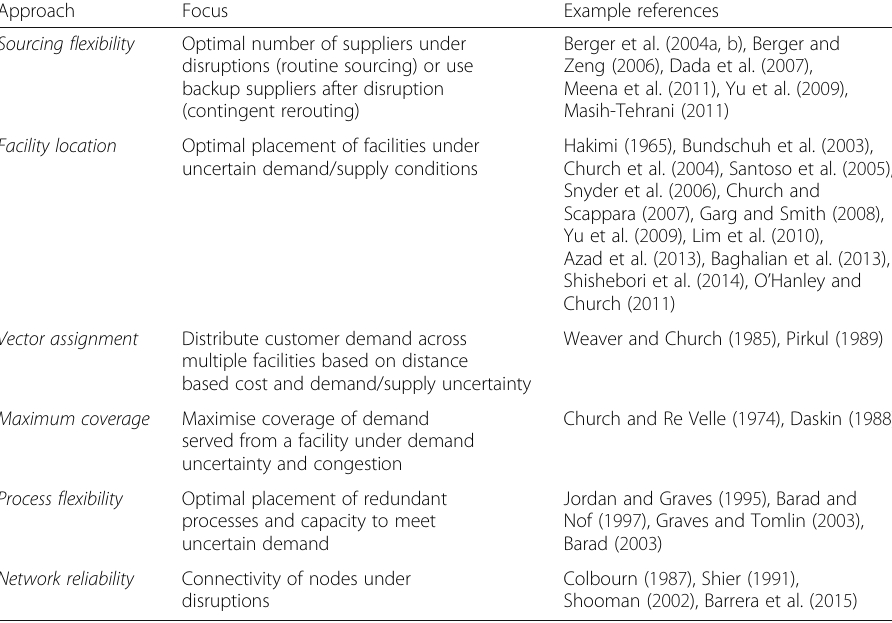
Table 1 Example approaches to reliable supply chain design optimisation Approach